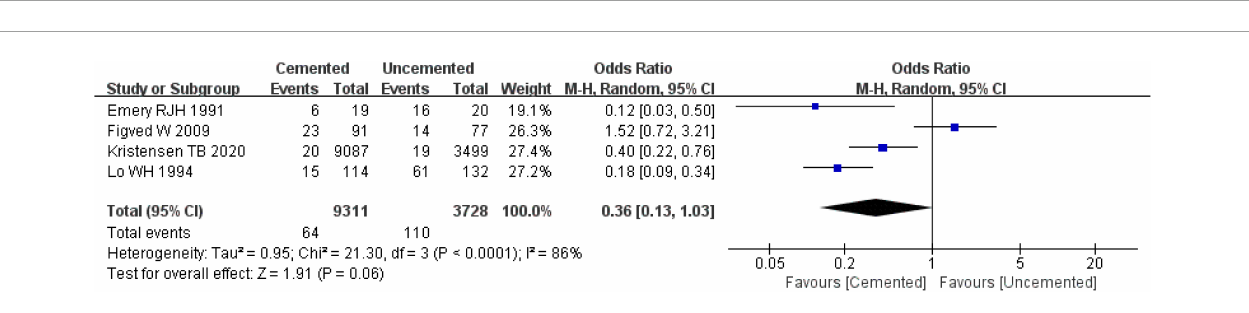
FIGURE8 Forest plot for comparison of residual pain at last follow-up between cemented bipolar hemiarthroplasty (CBH) group and uncemented bipolar hemiarthroplasty (UCBH) group.